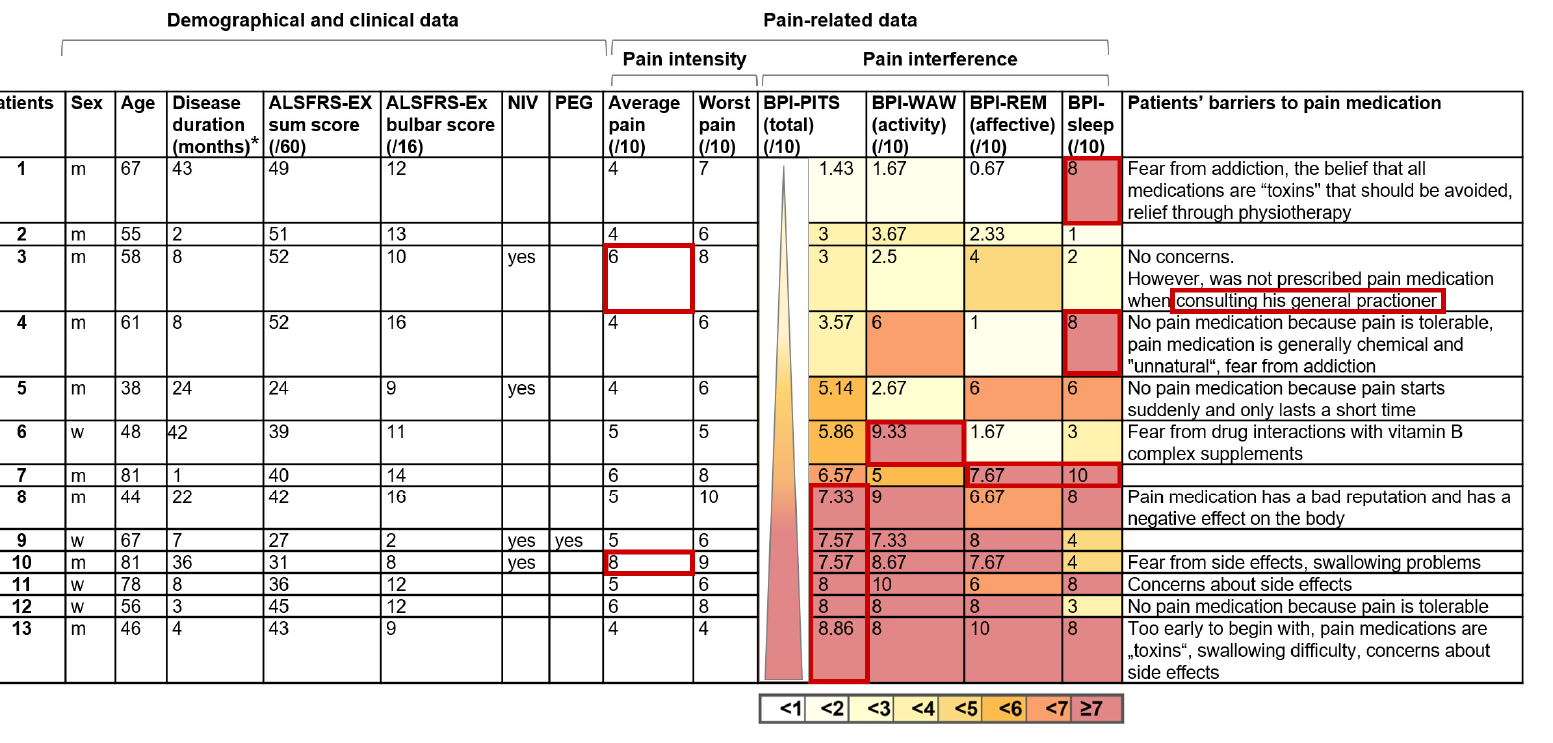
taneous endoscopic gastrostomy; BPI = Brief Pain Inventory; BPI-PITS = pain interference total score of the BPI; BPI-WAW = activity subdimension of the pain interference scale of the BPI; BPI-REM = affective subdimension of the pain interference scale of the BPI. Figure 5. Characteristics of the 13 patients who did not receive any pain medication and who reported an average NRS value ≥ 4. The figure summarizes the demographic, clinical and pain-related data as well as the patient-reported barriers to pain medication with the patients being arranged according to the BPI pain interference total score (BPI-PITS) in ascending order. Pain interference scores ≥ 7 were categorized as high and are highlighted in dark red. For visualization of the level of pain interference referring to the scores between 0 and 6, an additional color scale from white to shades of yellow and orange was used. The findings highlighted by dark red boxes prompted us to assume that the respective patients may benefit from adequate pain therapy.